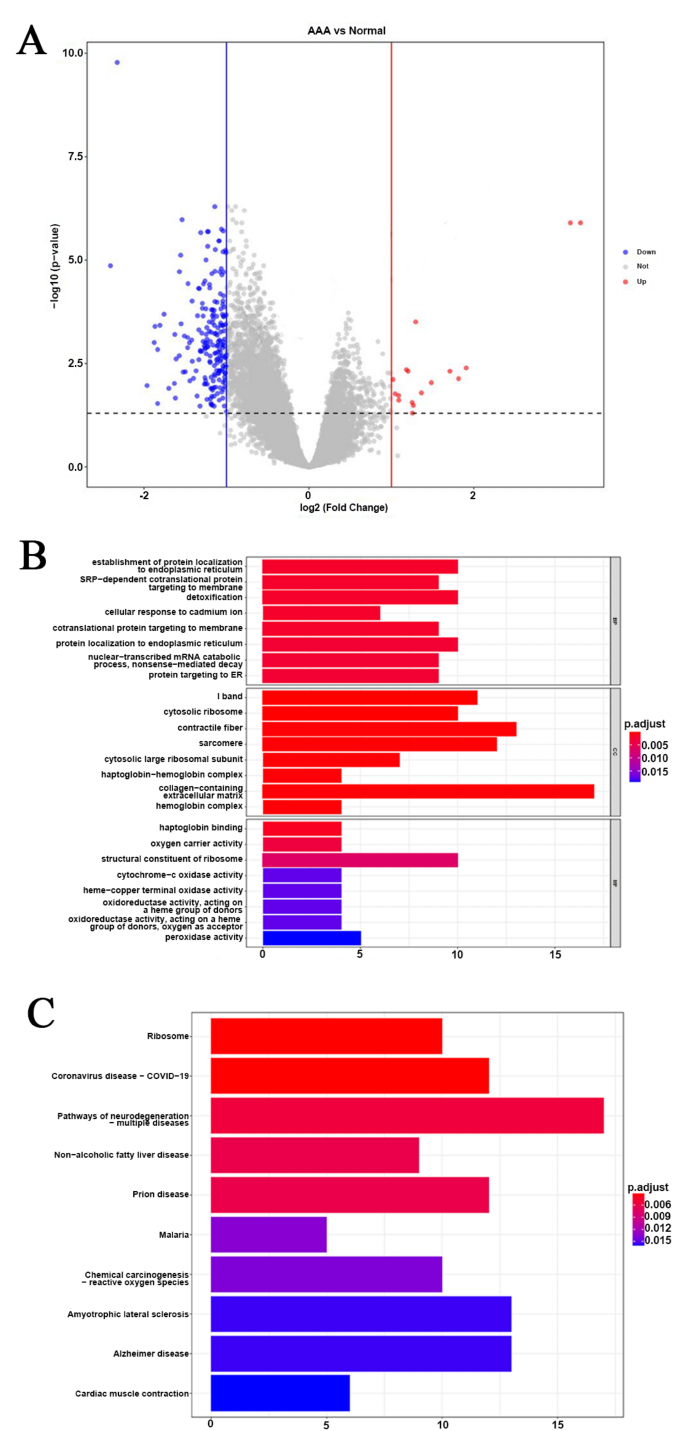
Figure 2. Identification of DEGs and analysis of their function in AAA. ( A ) Volcano plot of DEGs with cutoff value |log2 (FC)| > 1 and p -values < 0.05. ( B ) Bar charts of the GO analysis with FDR > 0.05, including BP, CC, and MF terms. ( C ) Bar charts of the KEGG pathway enrichment analysis with FDR >